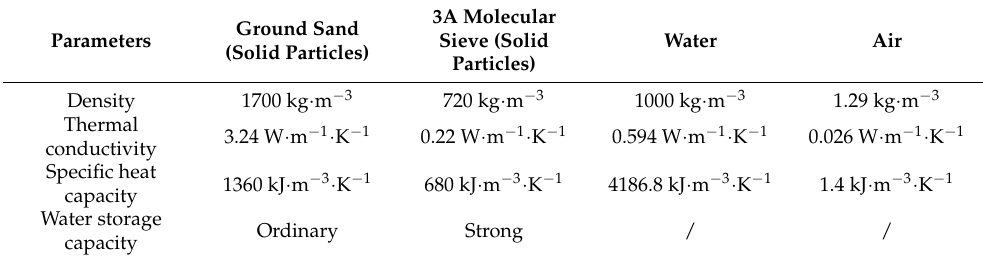
Table 1. Basic parameters of the materials.